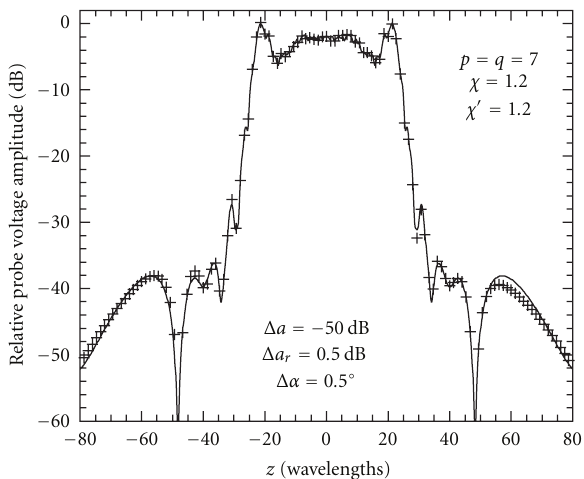
Figure 11: Amplitude of the probe output voltage V on the generatrix at ϕ = 0 ◦ . Solid line: measured. Crosses: interpolated.